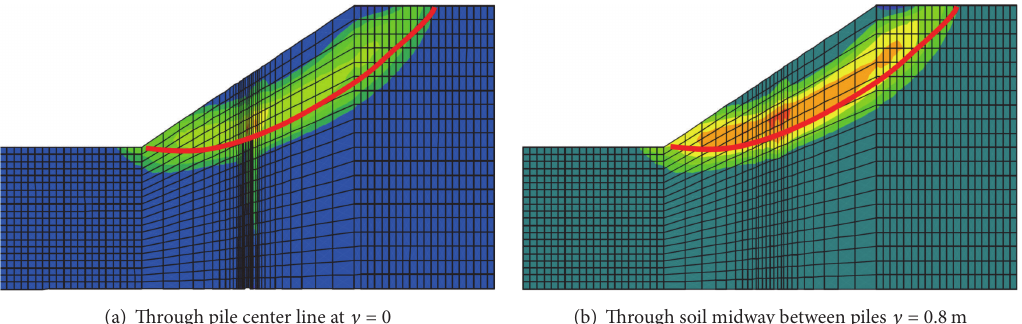
Figure 19: Failure mode of a slope with piles C = 1.05 at different sections (note: the solid line shows the potential slip surface of the unreinforced